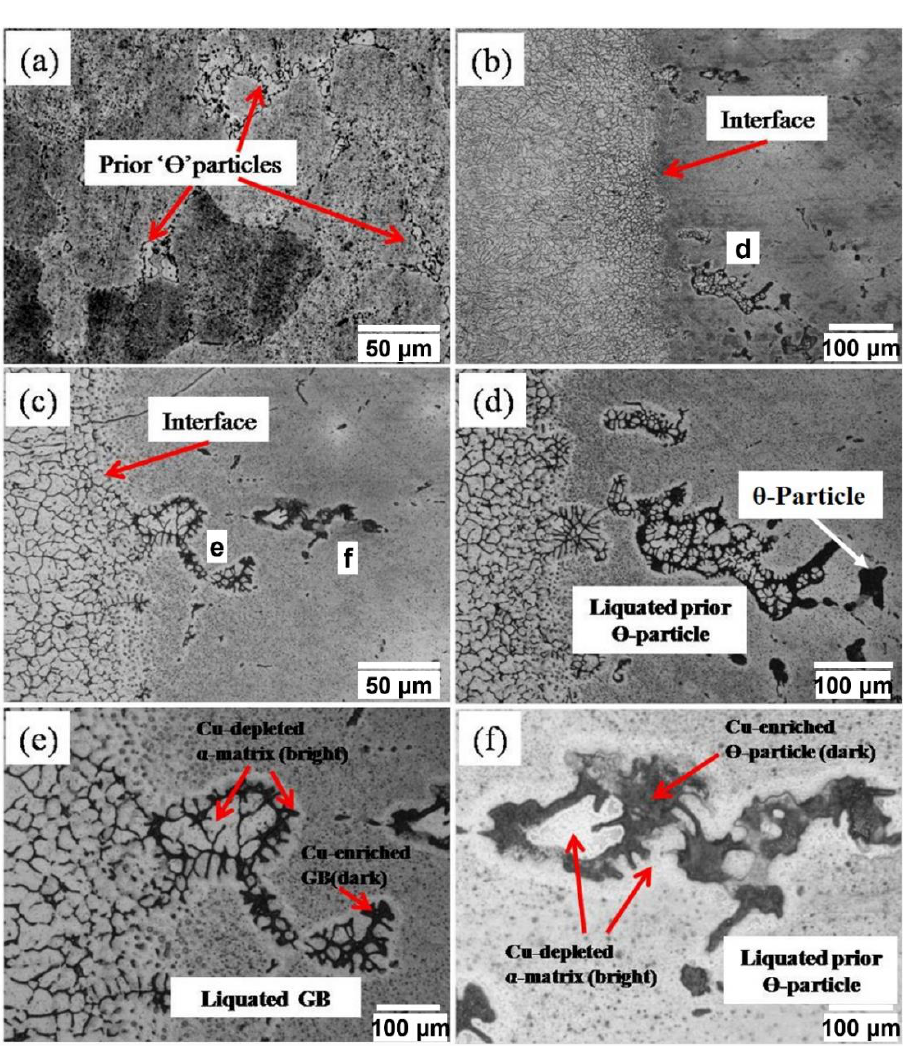
Figure 12. The low- and high-magnification microstructures of different locations of PMZ of AA 2219 side of dissimilar EB weld ( a ) base material of AA 2219 alloy; ( b , c ) fusion interface at AA 2219 alloy side of weld at two different locations; ( d ) liquated prior θ -particles in the location marked in ( b , e ) liquated GB in the location marked in ( c , f ) liquated prior θ -particles in the location marked in ( c ).